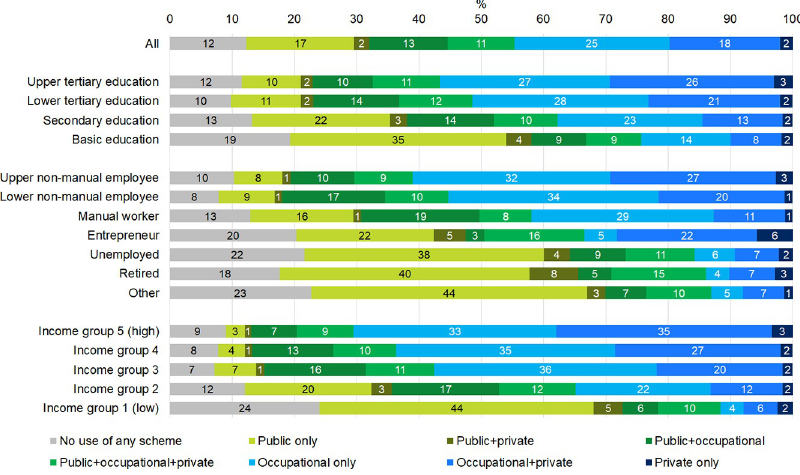
Fig 2. Unadjusted proportions of users of primary outpatient health care schemes during year 2013 among women according to socioeconomic variables. Residents of Oulu, Finland, women aged 25–64 in 2013 (N = 45 256).